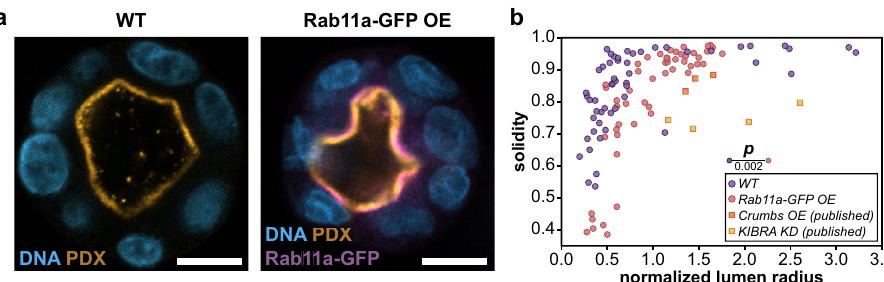
Fig. 4 Increasing apical domain size alters lumen shape. a Representative images of fi xed wildtype (WT, left) and overexpressing Rab11a-GFP (Rab11a- GFP OE, right, purple) MDCK spheroids immunostained for the apical surface protein Podocalyxin (PDX, orange) and DNA (blue). b Lumen solidity plotted as a function of normalized lumen radius for wildtype (WT, purple) and apical expansion manipulations (Rab11a-GFP OE red, Crumbs3a overexpression [OE], orange and KIBRA knockdown [KD], yellow; p -value from two-sided 2D Kolmogorov – Smirnov test). For plot b , n = 51 WT, 3 Crumbs3a OE 30 , 4 KIBRA KD 31 , and 51 Rab11a-GFP OE conditions. Scale bars are 10 µ m. Source data are provided in the Source Data fi